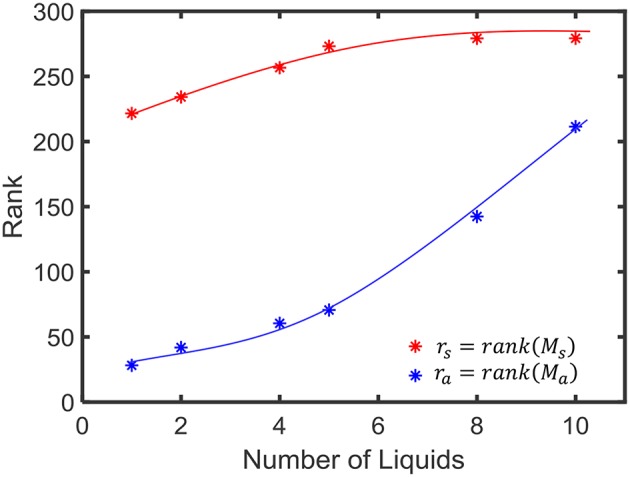
The average rank of state matrix Ms that indicates the inter-class separability (in red) and the average rank of the matrix Ma which is an indication of the intra-class generalization capability (in blue).